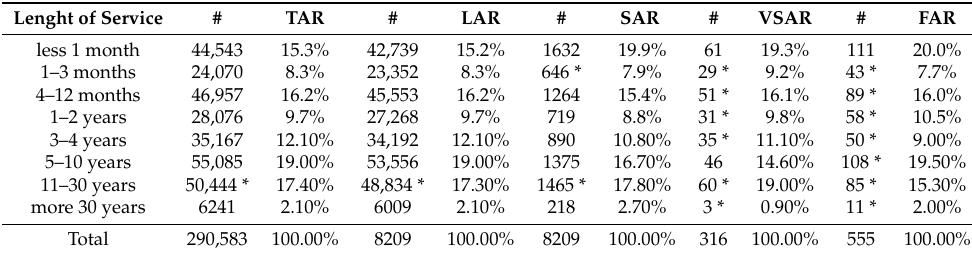
Figure 2. Difference of TAR-FAR based on length of service. Table 6. Length of